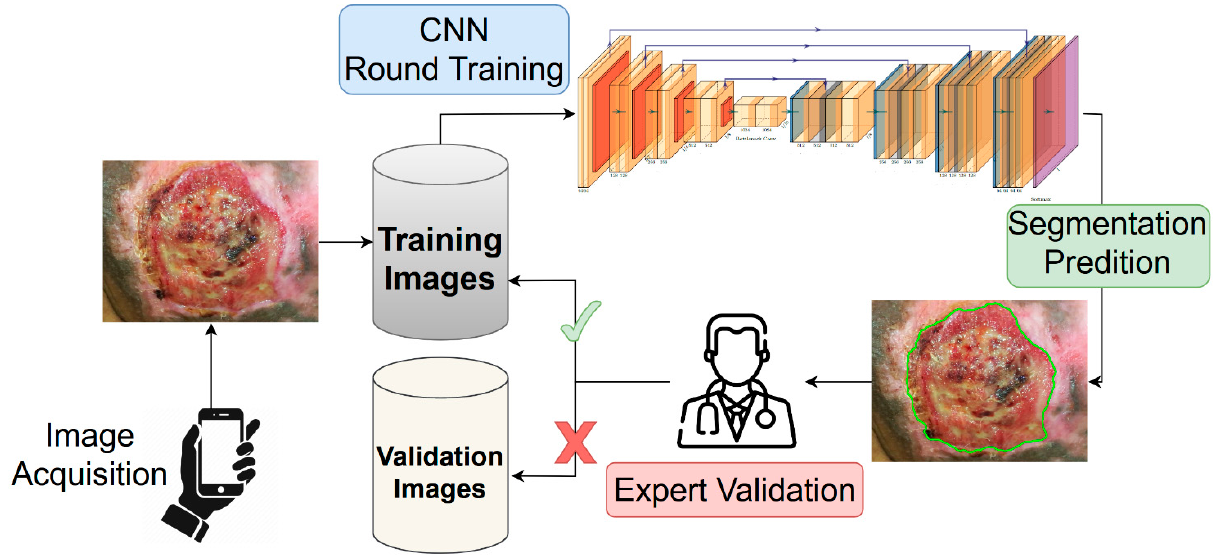
Figure 2. Representation of the active semi-supervised learning strategy implemented for the training of the wound segmentation model. The images acquired using a smartphone were stored into the training dataset. Starting with a small set of annotated images (not included into the scheme), we trained from scratch a neural network model for the wound segmentation. All of the unlabeled images were used as validation set, and the generated masks were provided by the expert. The expert analyzed the produced segmentation according to a predetermined evaluation criterion. The masks which satisfied the criteria would be added as ground truth for the next round of training.